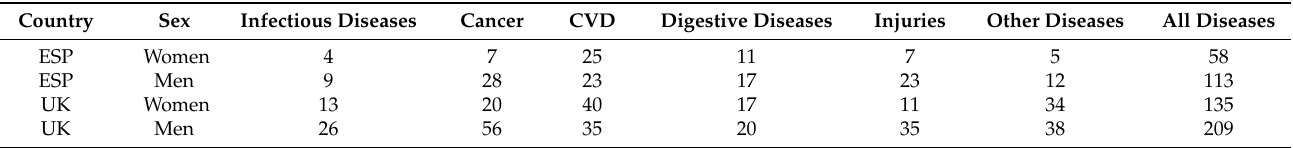
Table A2. Cumulative causes of death averted by the introduction of beer and wine with less than 0.5% alcoholic strength in Spain and the UK over a 5- and 6-year period,